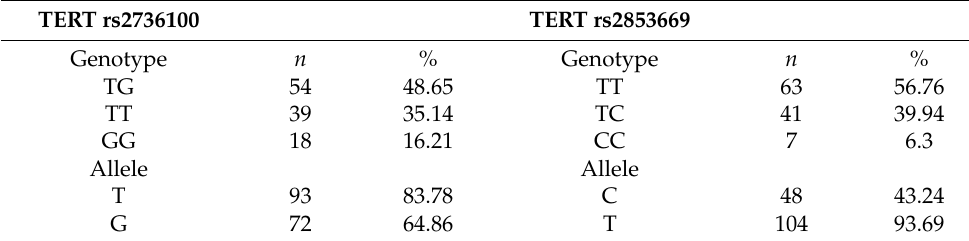
Table 2. Prevalence of TERT SNPs in the entire study group. TERT rs2736100 TERT rs2853669 Genotype